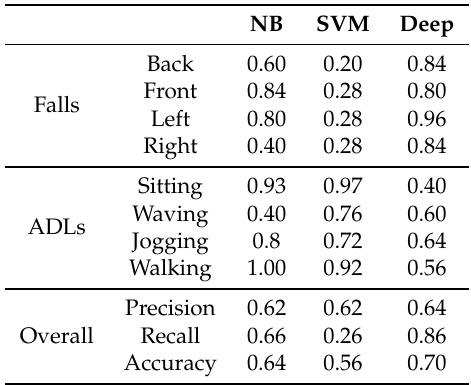
Table 3. Online results by